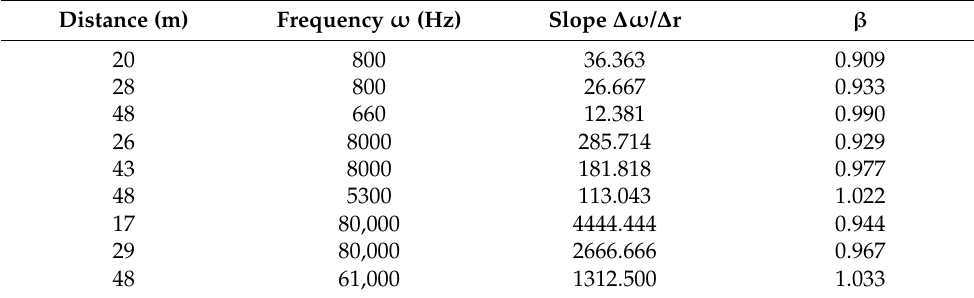
Table 1. The slopes and waveguide invariants for the monostatic configuration.